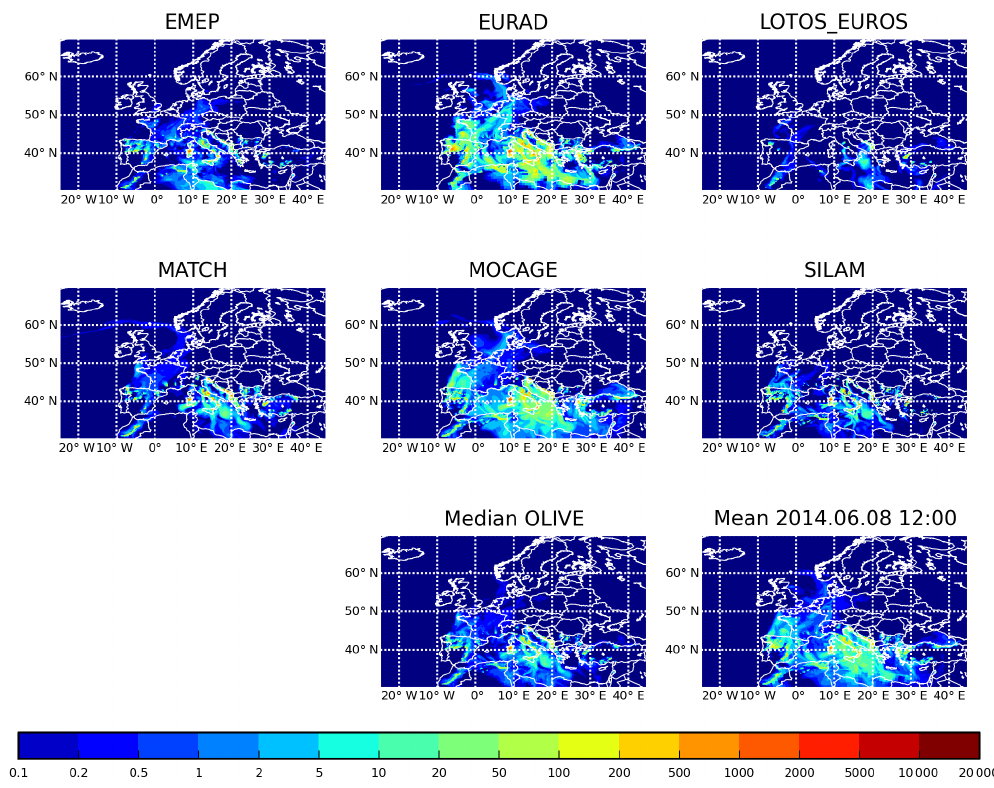
Figure 5. Example of hourly olive pollen concentrations: 12:00UTC on 8 June 2014 [pollenm − 3